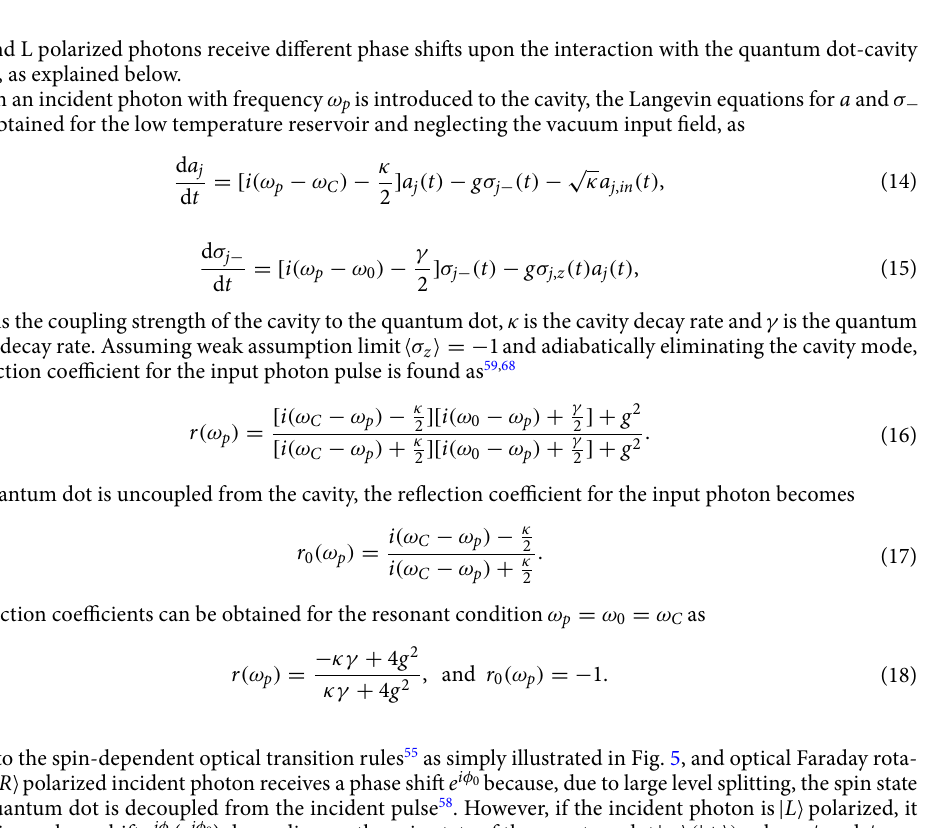
e e and are |−� ↔ | � |+� ↔ | � L R and | � | �